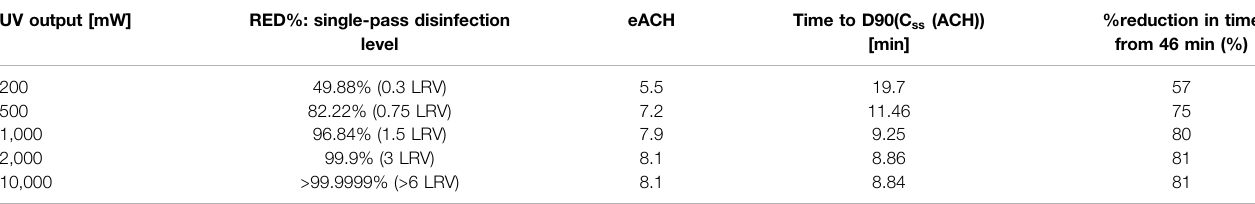
TABLE 3 | Effect of UVC on the eACH and time to D90( C ss (ACH)) in a 50 m 3 room with existing ACH (cid:1) 3. The UV chamber parameters are 160 m 3 /h recirculation rate and 70% internal re fl ectivity, and wavelengths are normalized to 265 nm. UV output [mW]